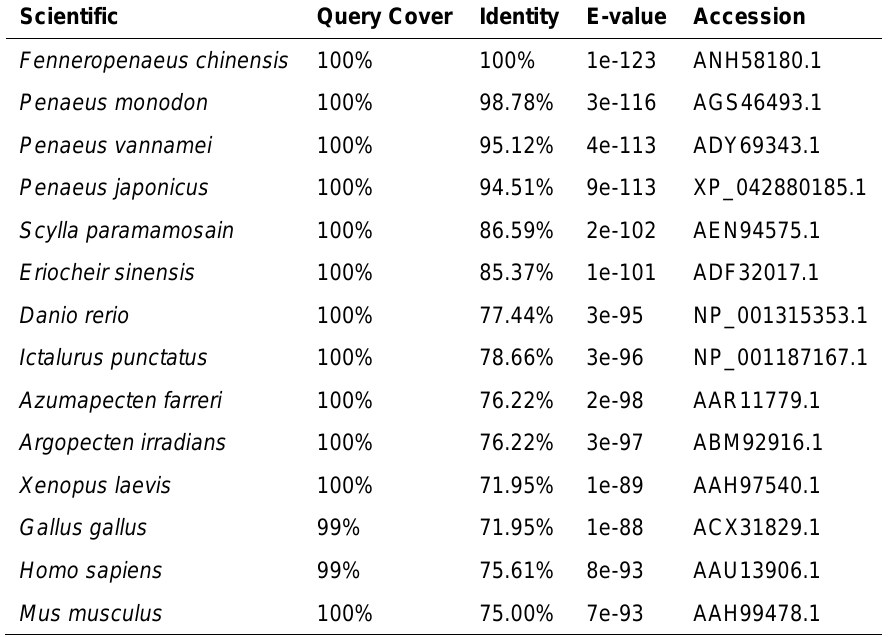
Table 2 Species and accession number of CypAs used in the homologous and phylogenetic analysis Scientific Query